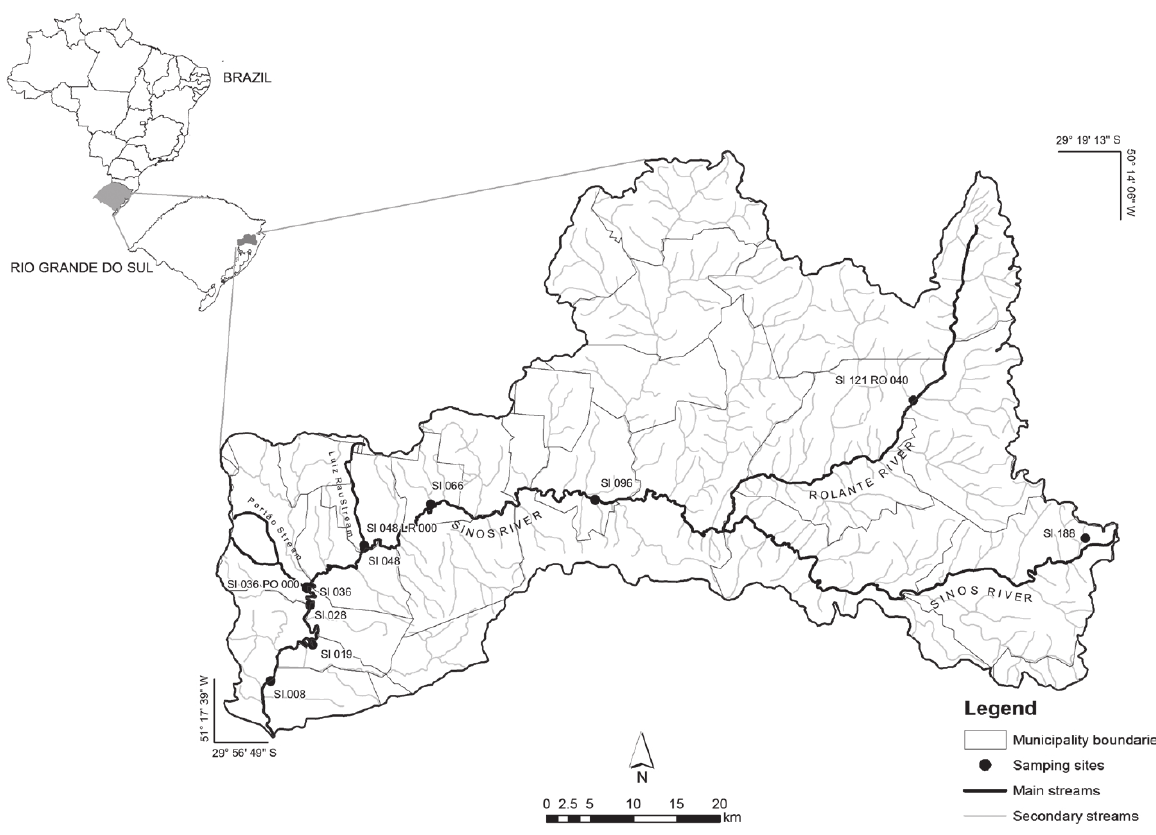
Fig. 1 - Study area with the sampling sites in the Sinos River